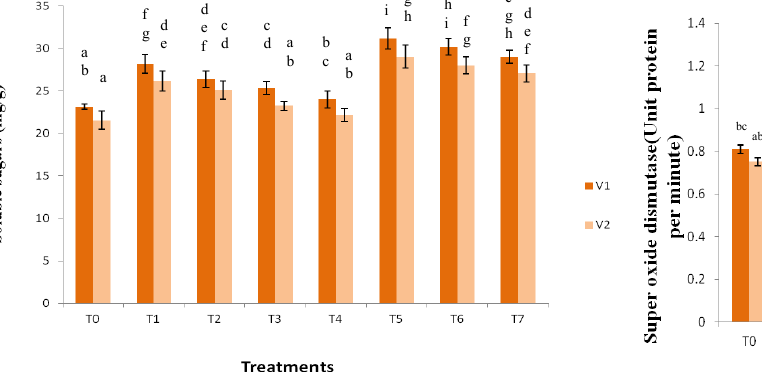
Fig. 4A: Effect of Azospirillum inoculation on super oxide dismutase of two canola varieties (v1 and v2) grown under drought stress. Where, To = Un-inoculated and well watered, T = Un-inoculated and drought exposed, T2 = Seed inoculated and well watered, T3 = Rhizosphere inoculated and well watered, T4 = Seed inoculated with heat killed inoculums and well watered, T5 = Seed inoculated and drought exposed, T6 = Rhizosphere inoculated and drought ex- posed, T7 = Seed inoculated with heat killed inoculums and drought exposed. And V1 = Rainbow, V2 = Con